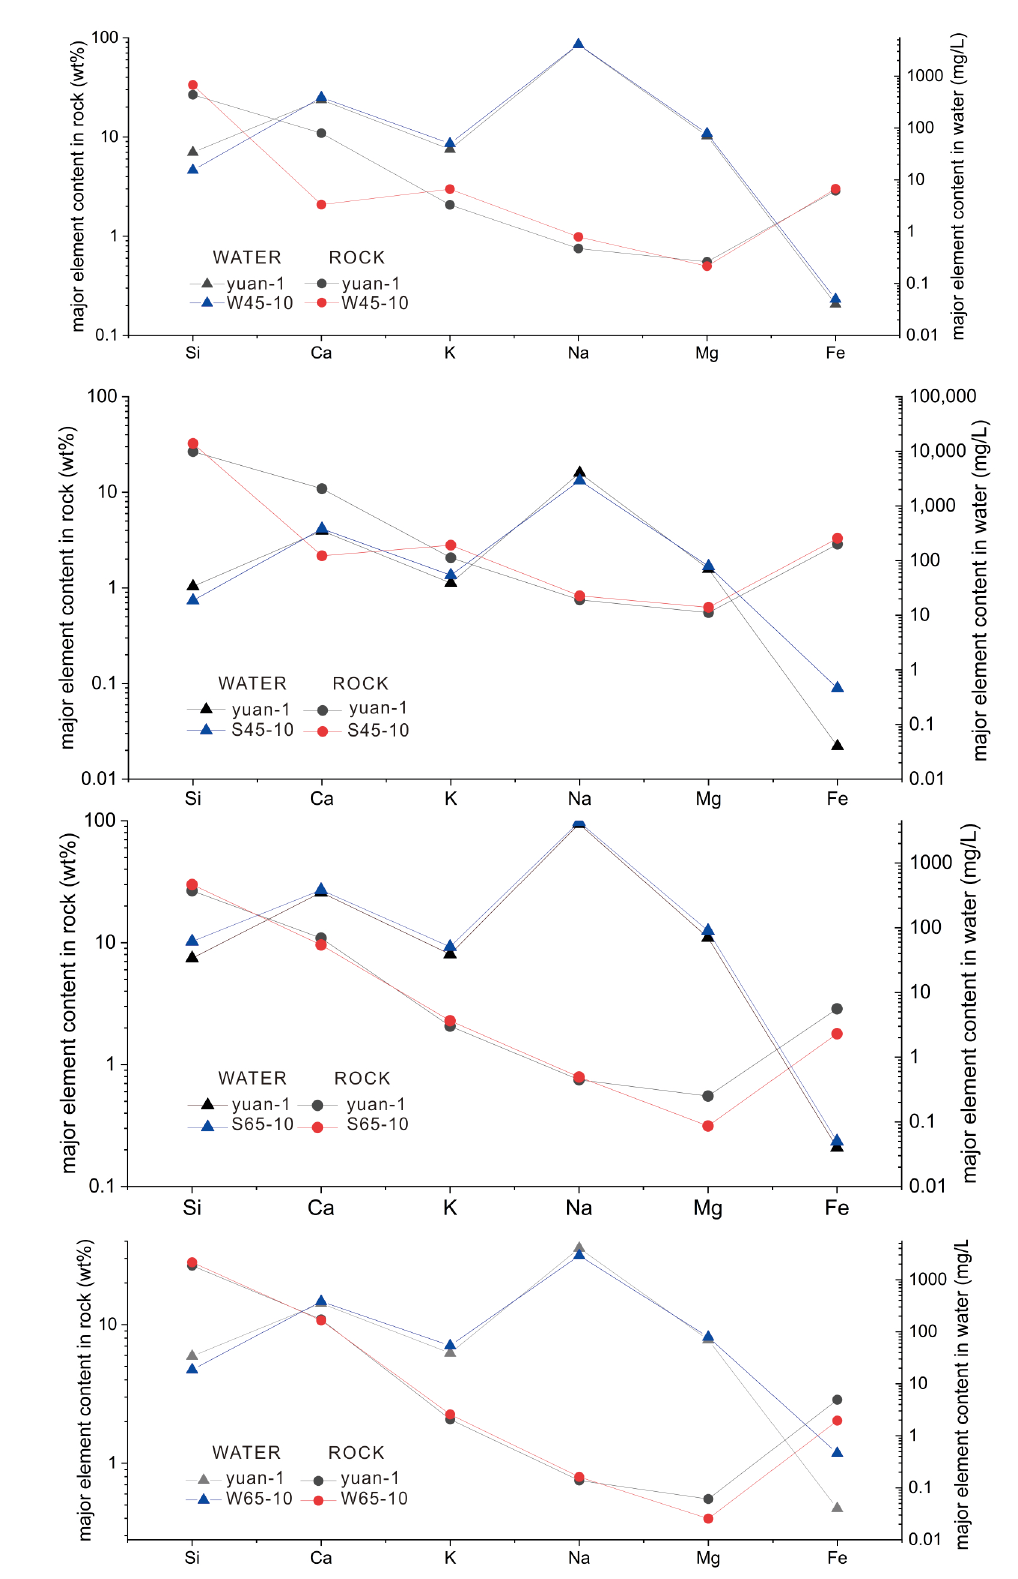
Figure 5. Major element comparison of water and rock. The change in content of Si in water is denoted as H 4 SiO 4 , and in rock, is denoted as